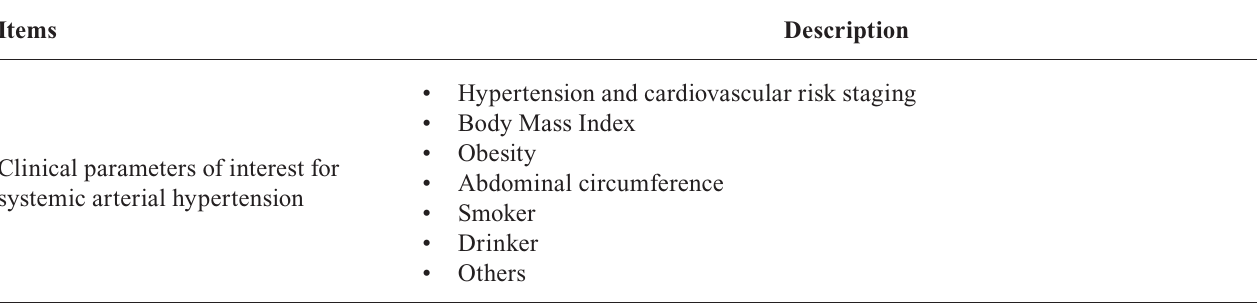
TABLE V - Checklist for Data extraction in this protocol and building the worksheet for databank